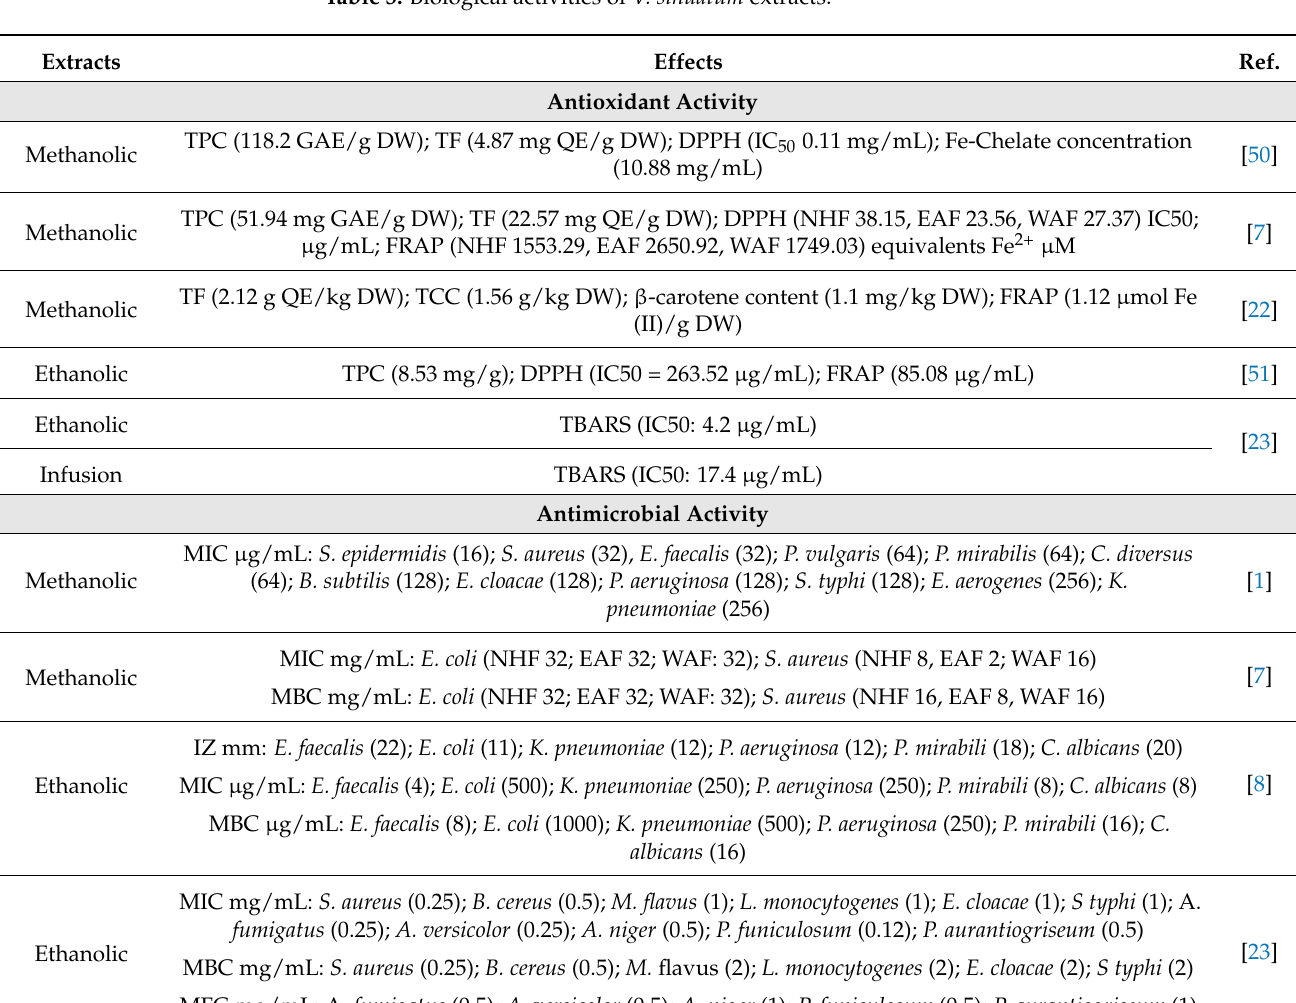
Table 3. Biological activities of V. sinuatum